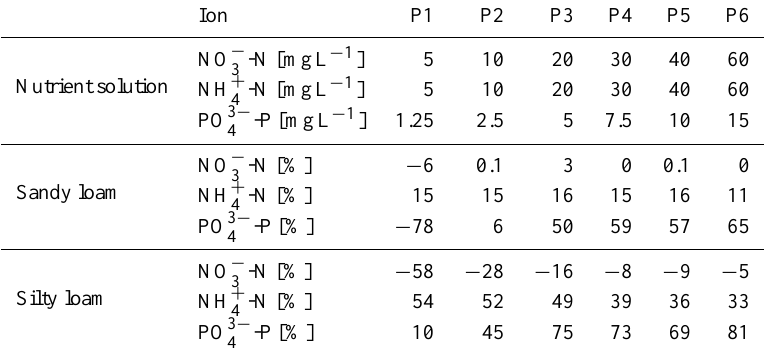
Table 3. Ion concentrations of the nutrient solution and relative sorption rates of the two control soils (soil without application of char) at the six applied concentration